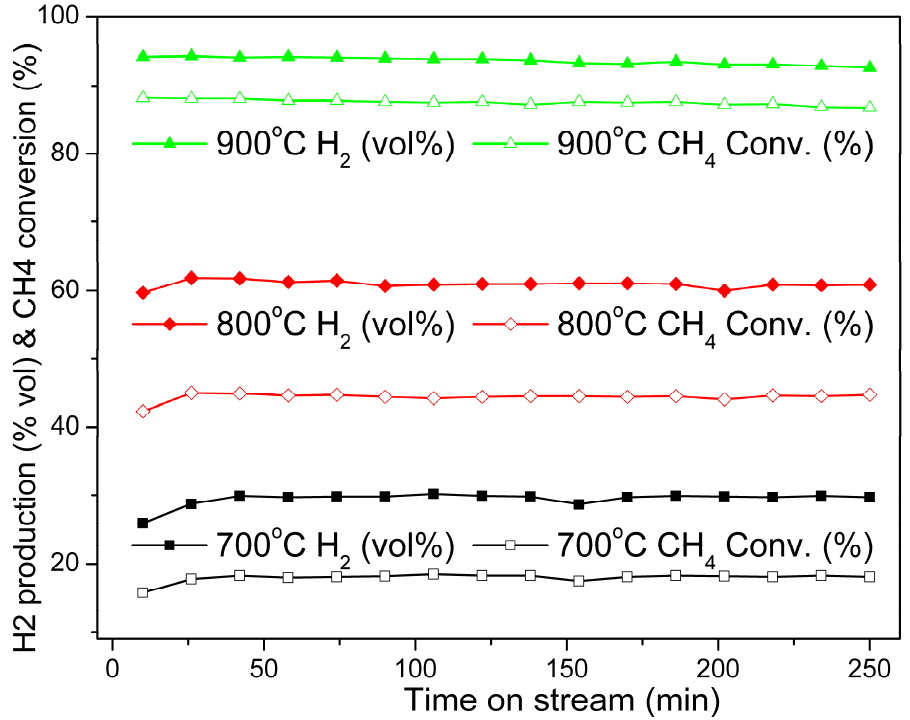
Figure 6. Effect of the reaction temperature on catalytic decomposition of methane over 25.5% Ni@G nanoparticles. Catalyst used: 10 g; gas flow rate: 100 mL/min; testing temperature: 700 ◦ C, 800 ◦ C, and 900 ◦